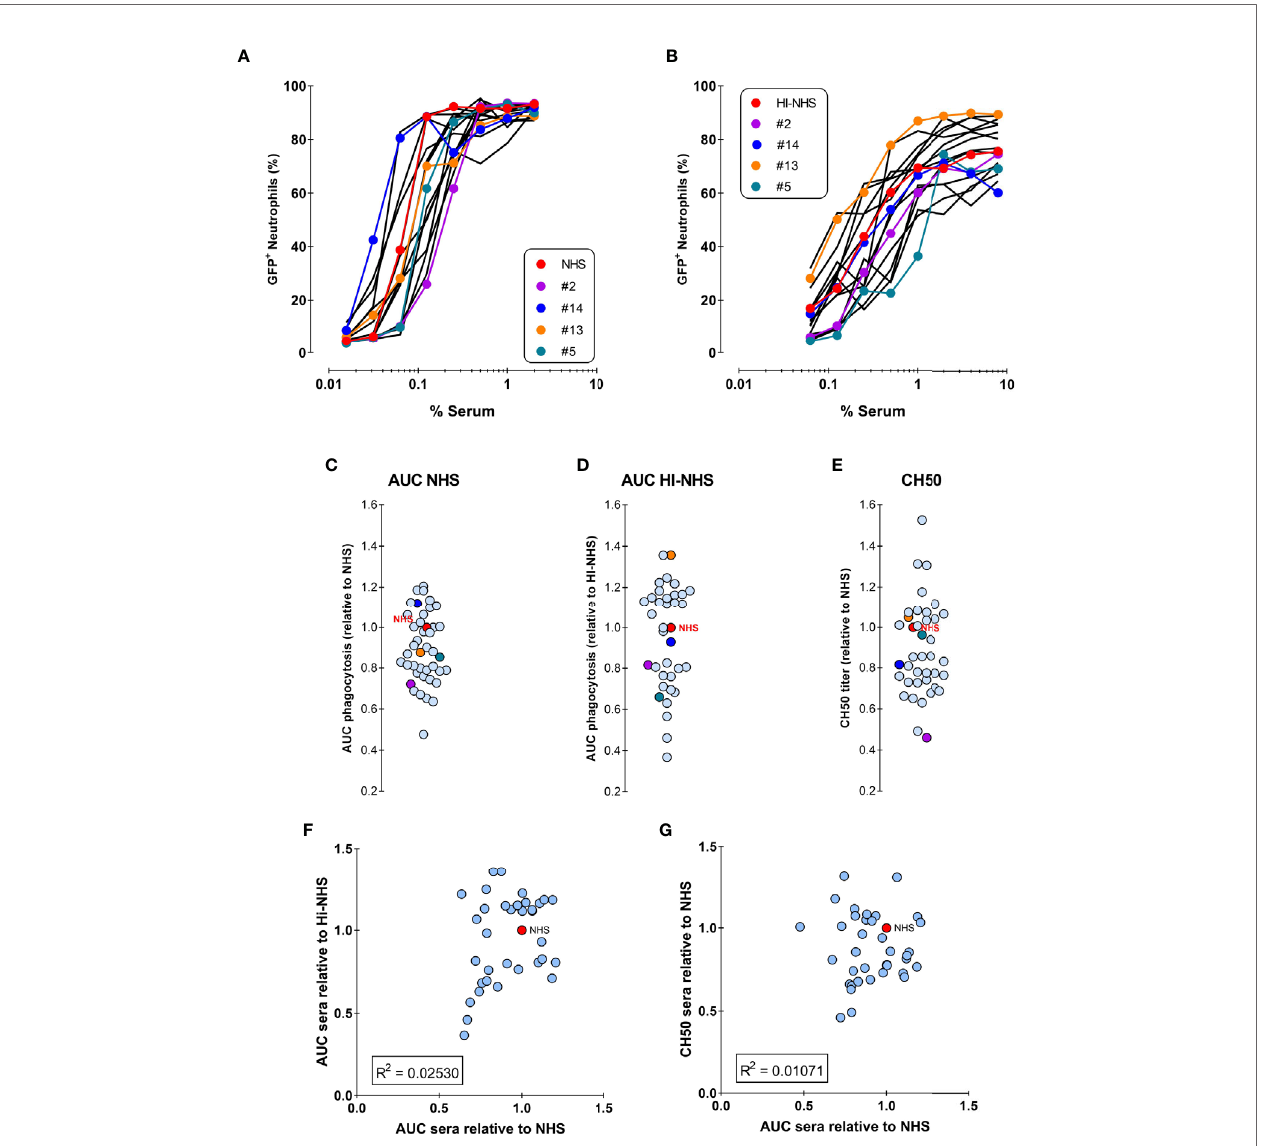
FIGURE 5 | No correlation between phagocytosis by NHS versus HI-NHS or complement activity. (A, B) Phagocytosis of individual sera as compared to the same sera present in the pooled NHS expressed as % GFP+ neutrophils for NHS (A) and Heat-Inactivated serum (HI-NHS), without complement activity (B) . Representative experiment for 16 individual sera and their pool (NHS) with some color coded for comparison. C – E ) AUC value for each individual serum curve expressed relative to NHS phagocytosis ( C ; n=40), HI-NHS phagocytosis ( D ; n=37), and CH50 value relative to NHS ( E ; n=37). (F, G) No correlation between phagocytosis AUC for NHS versus HI-NHS (F) or for phagocytosis versus CH50 for NHS (G) with